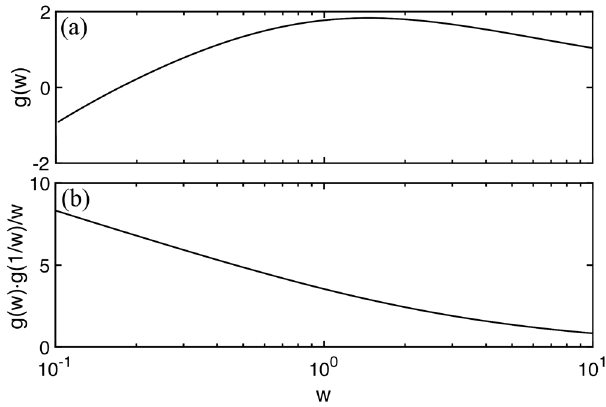
FIG. 2. (a) the scattering function g ð w Þ and (b) its product g ð w Þ g ð 1 =w Þ =w